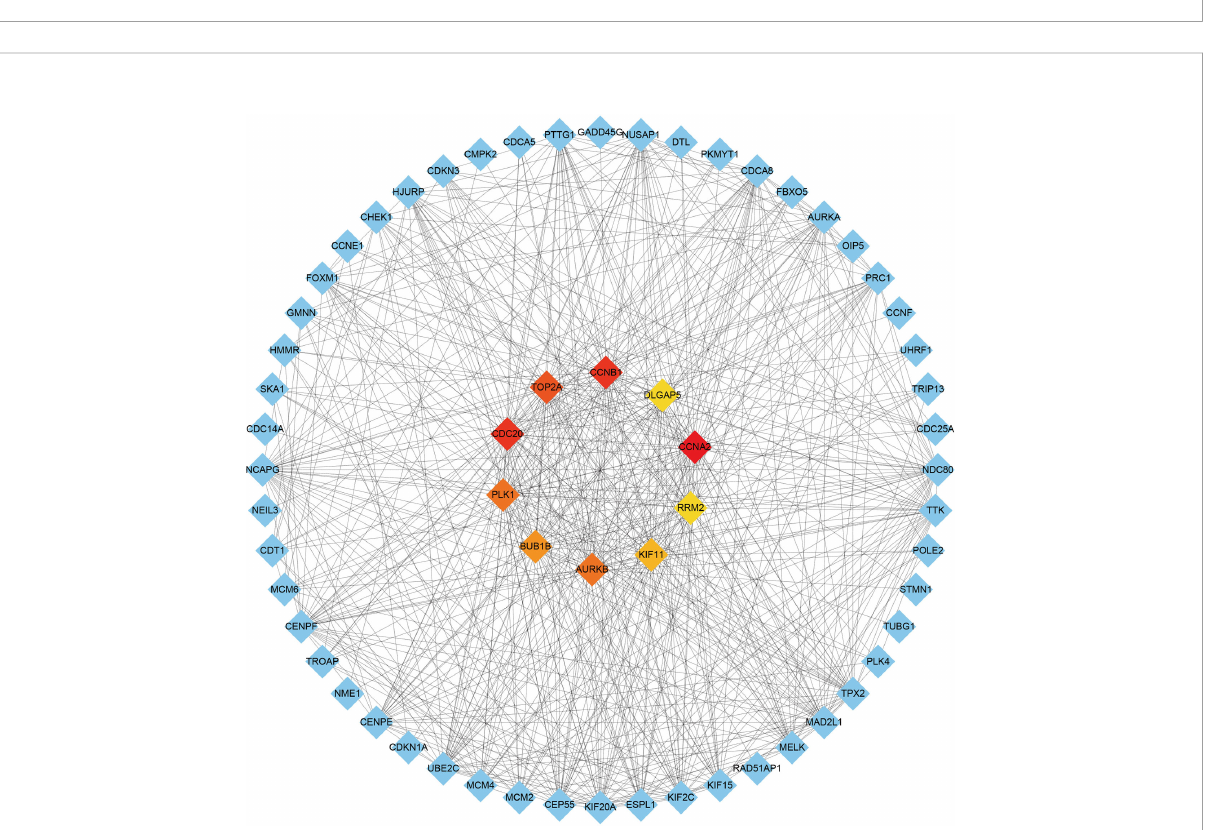
FIGURE 5 Identi fi cation of the top 10 hub genes ranked by their scores. In the middle circle, the 10 central genes represent the top 10 hub genes ranked by their scores and their interactions with other common